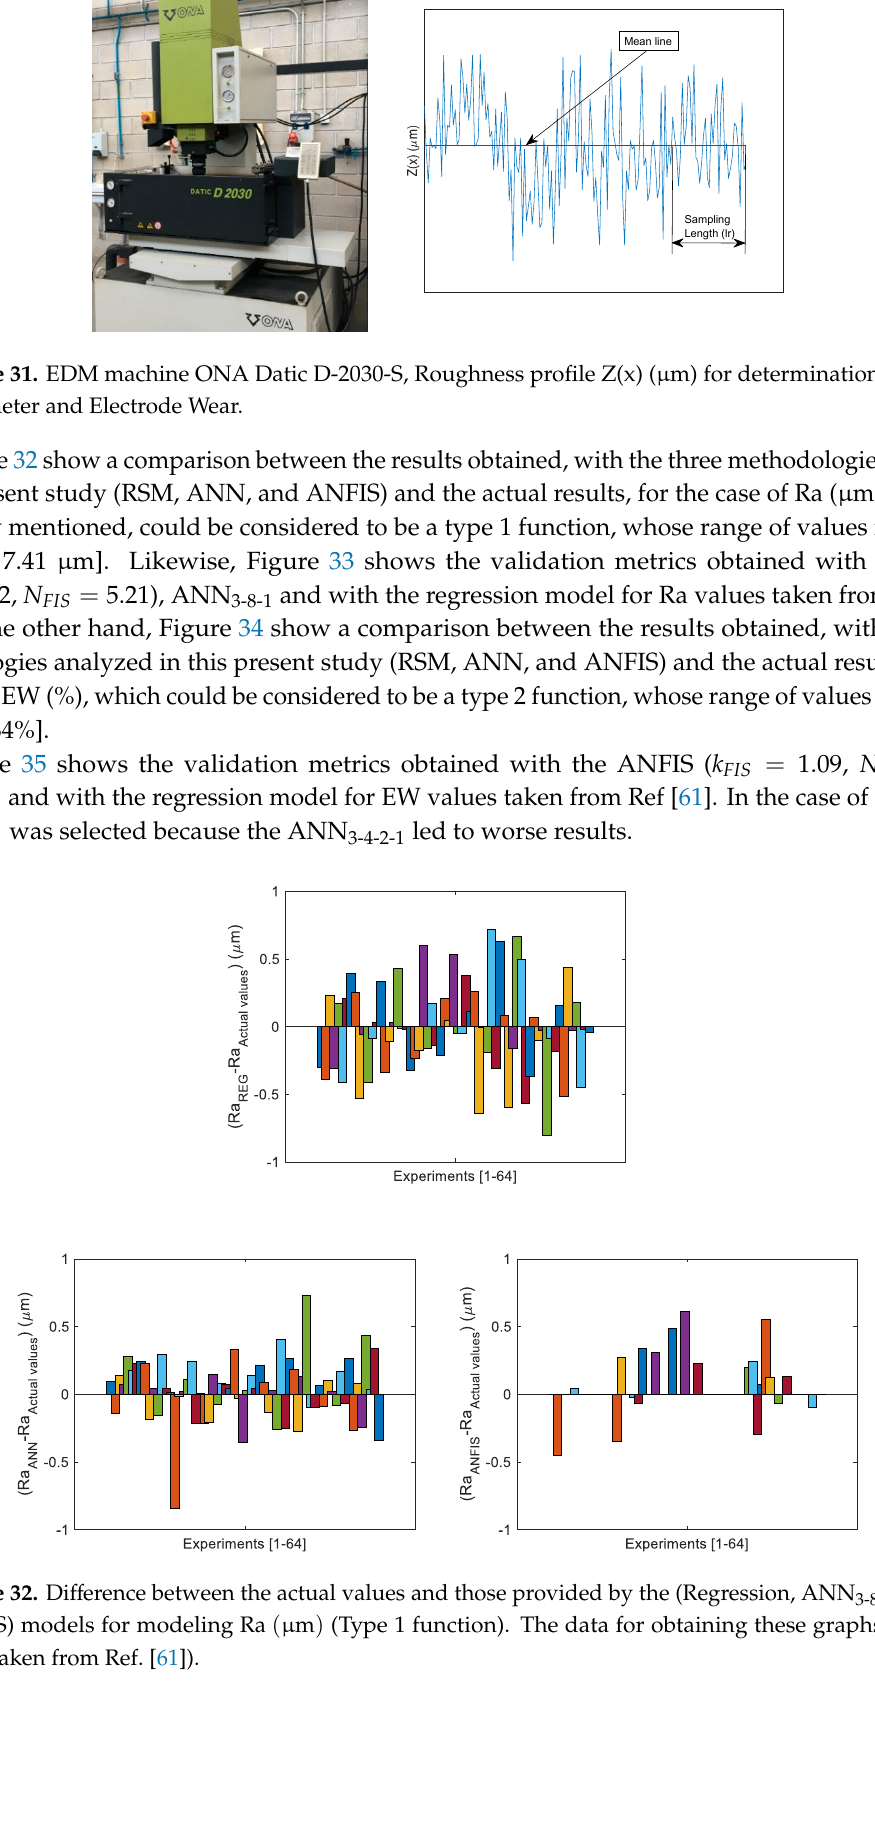
Figure 33. Validation metrics for the (ANFIS, ANN 3-8-1 , Regression) models. Type 1 function (Ra). The data for obtaining these graphs have been taken from Ref. [61]).